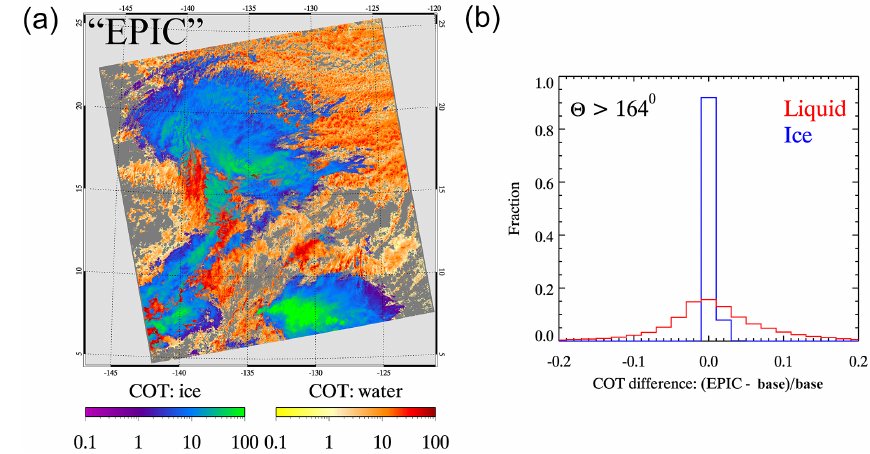
Figure 7. (a) Proxy EPIC COT retrievals corresponding to the Aqua MODIS granule in Fig. 2, as well as (b) the distribution of relative single-channel COT retrieval differences (i.e., errors) with respect to the baseline two-channel COT-CER retrievals for liquid (red line) and ice (blue line) phase clouds; the retrieval errors are for the pixel subset having scattering angle greater than 164 ◦ .